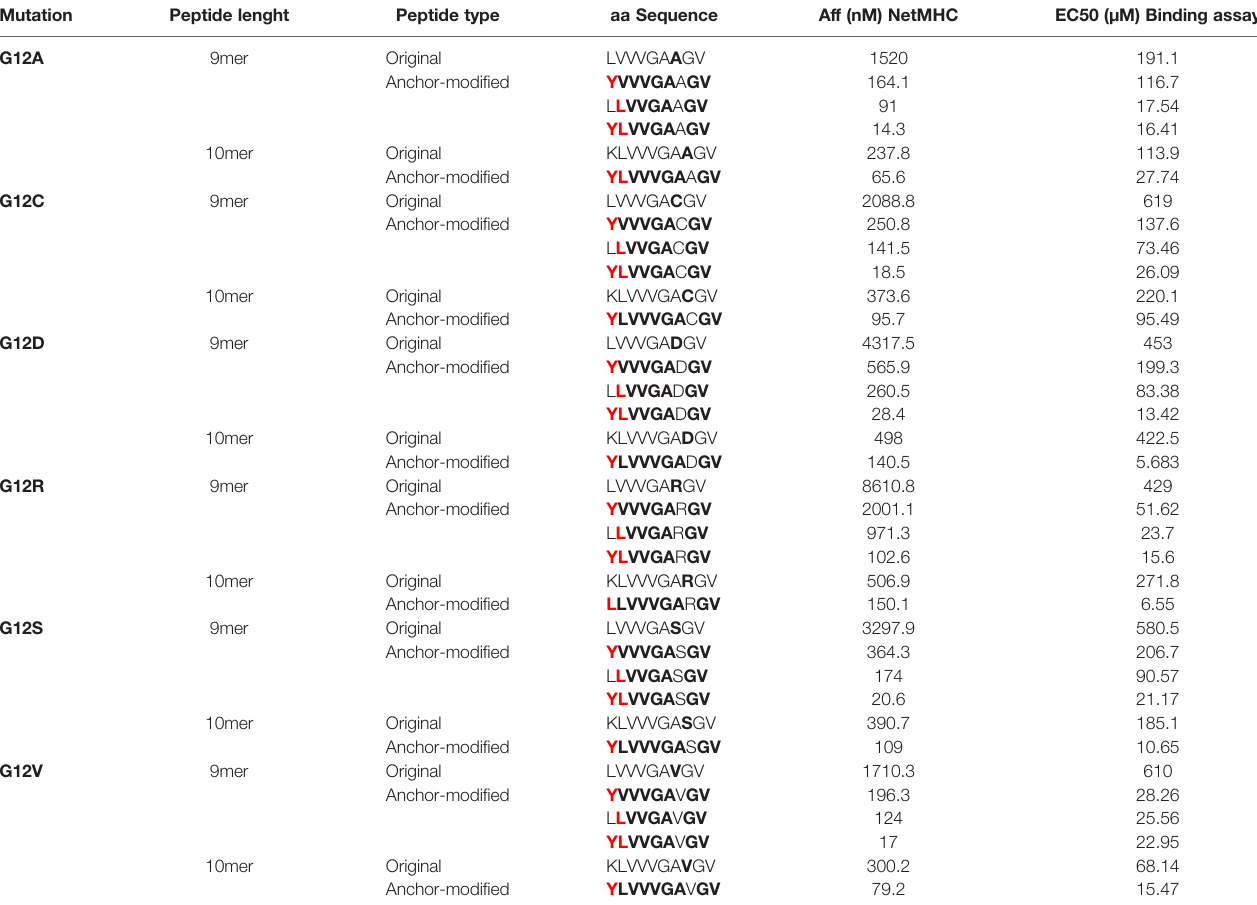
TABLE 1 | Predicted vs actual binding capacity of mutant original and anchor-modi fi ed RAS peptides. Mutation Peptide